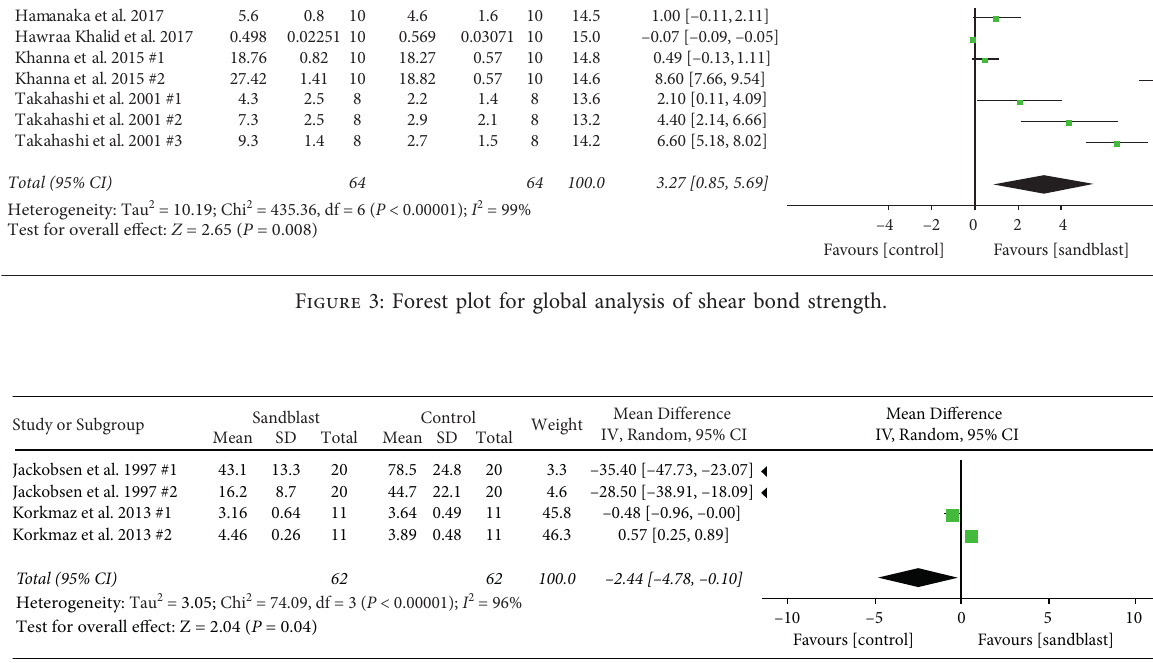
Figure 4: Forest plot for global analysis of peel bond